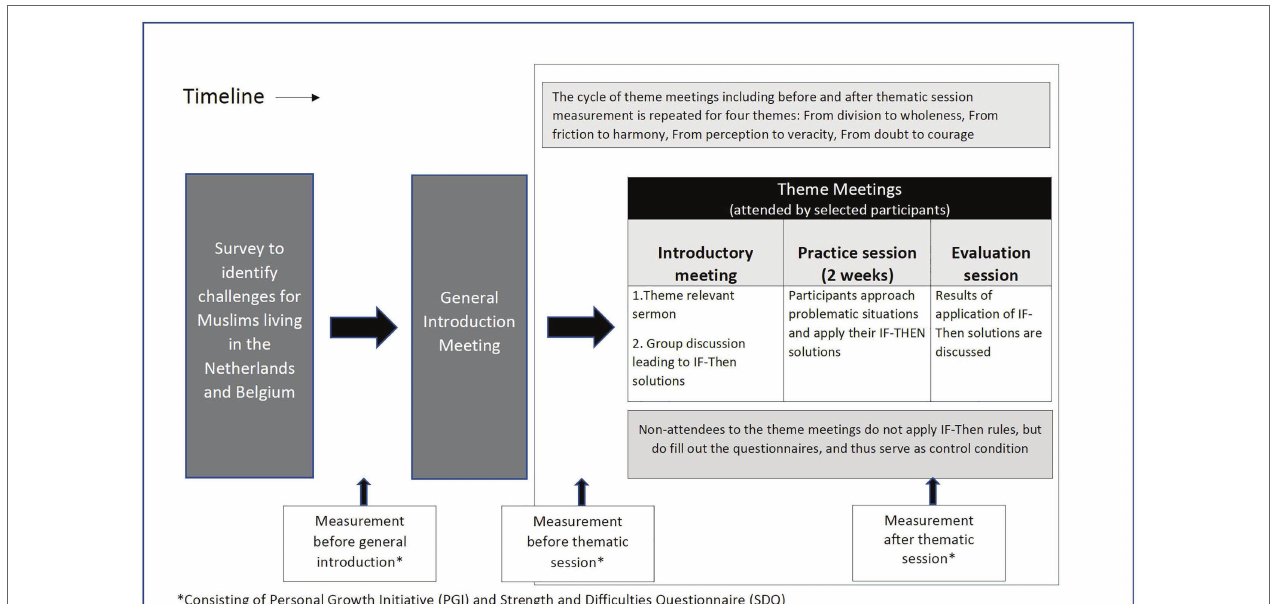
FIGURE 1 | Schematic overview of the design of the